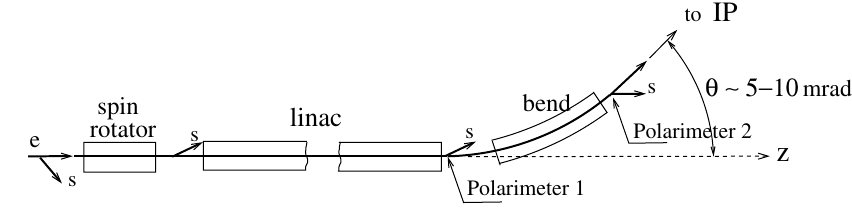
FIG. 1. Scheme of the energy measurement at linear colliders using the spin